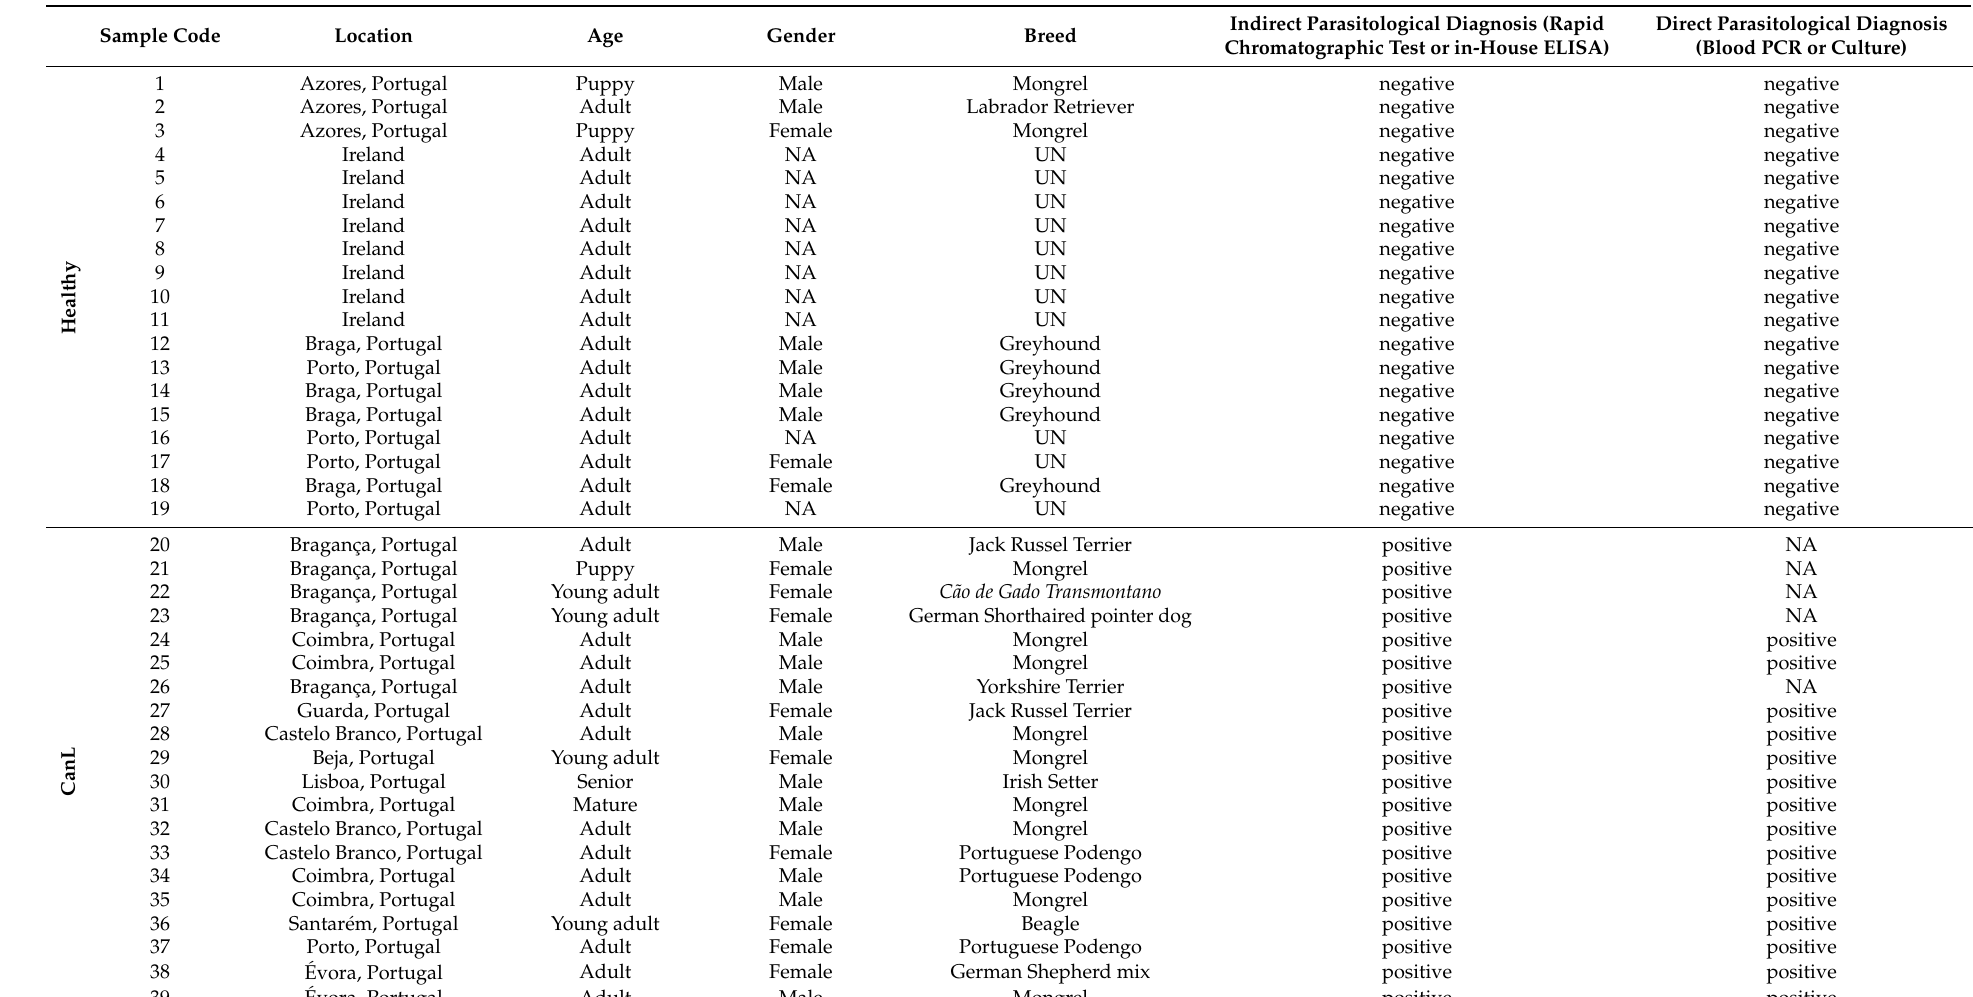
Table 1. Characterization of the Healthy and CanL